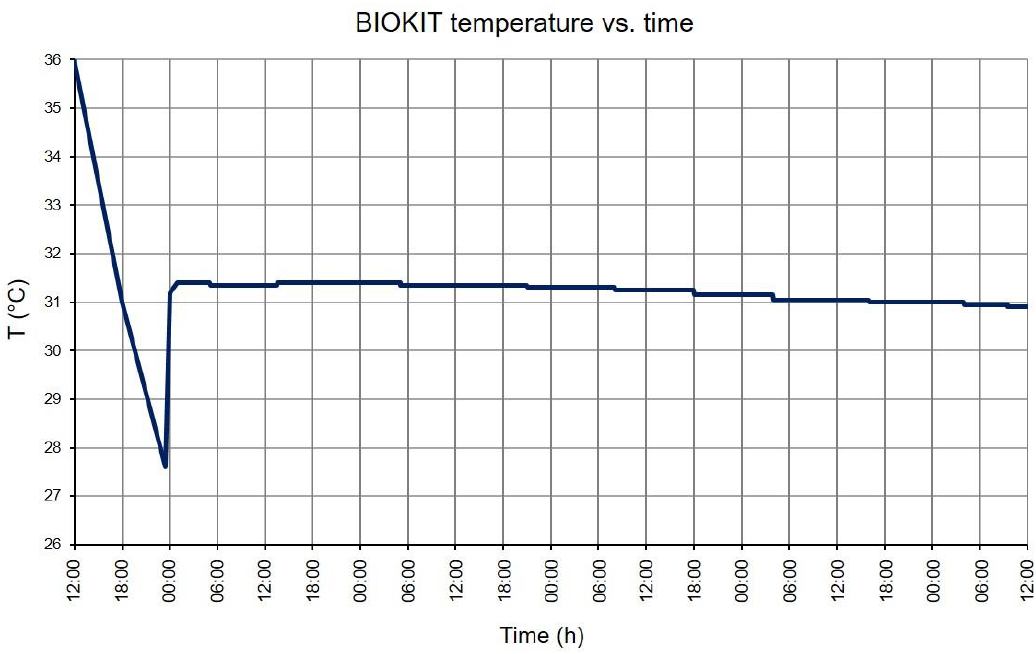
Figure 2. The T ( ◦ C) profile over time (h) in the worst-case scenario during the transport of EUs inside the KIC-SL containers and inside the TBC transportation container until the integration into the KUBIK on board the